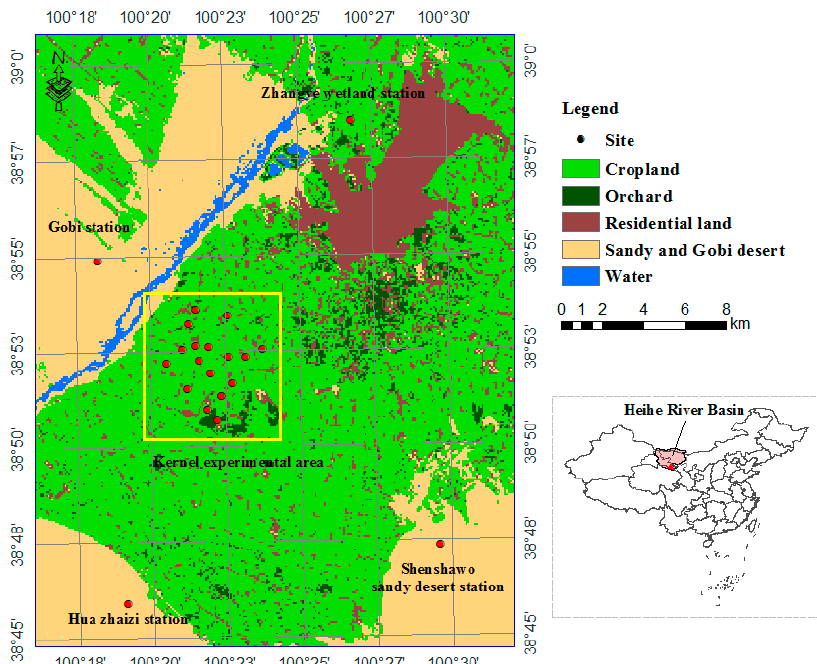
Figure 4. The distribution of flux towers and the land use classifications in the Multi-Scale Observation Experiment on Evapotranspiration (MUSOEXE) over Zhangye oasis. The yellow rectangular in the left figure shows the kernel experimental area in MUSOEXE, and the subset figure in the lower right shows the location of MUSOEXE (marked in red triangle) in the Heihe River Basin and in China.